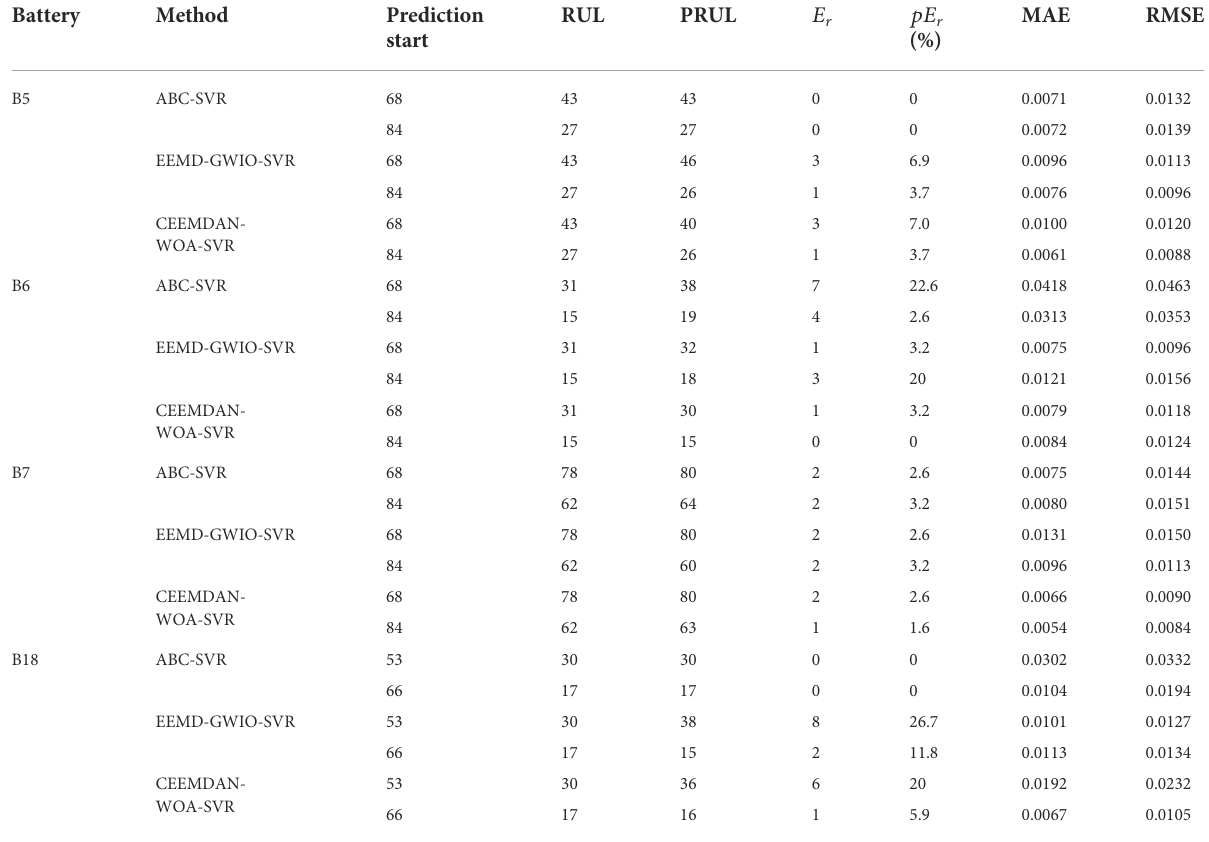
TABLE 4 The RUL prediction results of CEEMDAN-WOA-SVR and other methods. Battery